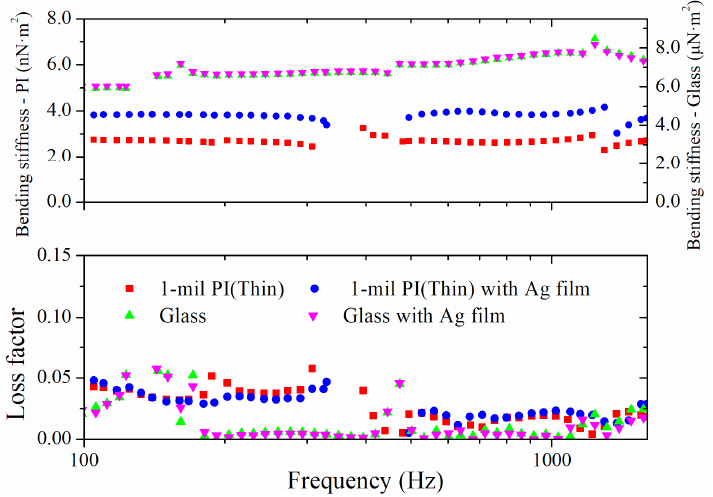
Figure 5. Measured bending stiffness and loss factor of the bare substrates and the Ag-printed beams.